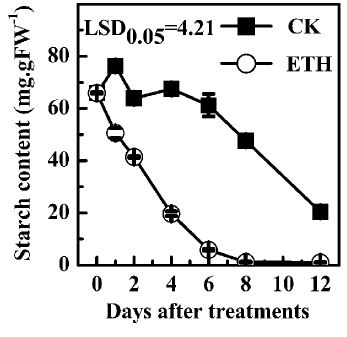
Figure 2. Effect of ethylene treatment (ETH, 100 µL/L, 24 h) on starch content in “Hayward” kiwifruit at 20 °C. CK, the control at 20 °C. Error bars represent ±strandard errors (SE) from three replicates. FW, fresh weight. Least significant difference (LSDs) represent least significant difference at p = 0.05.